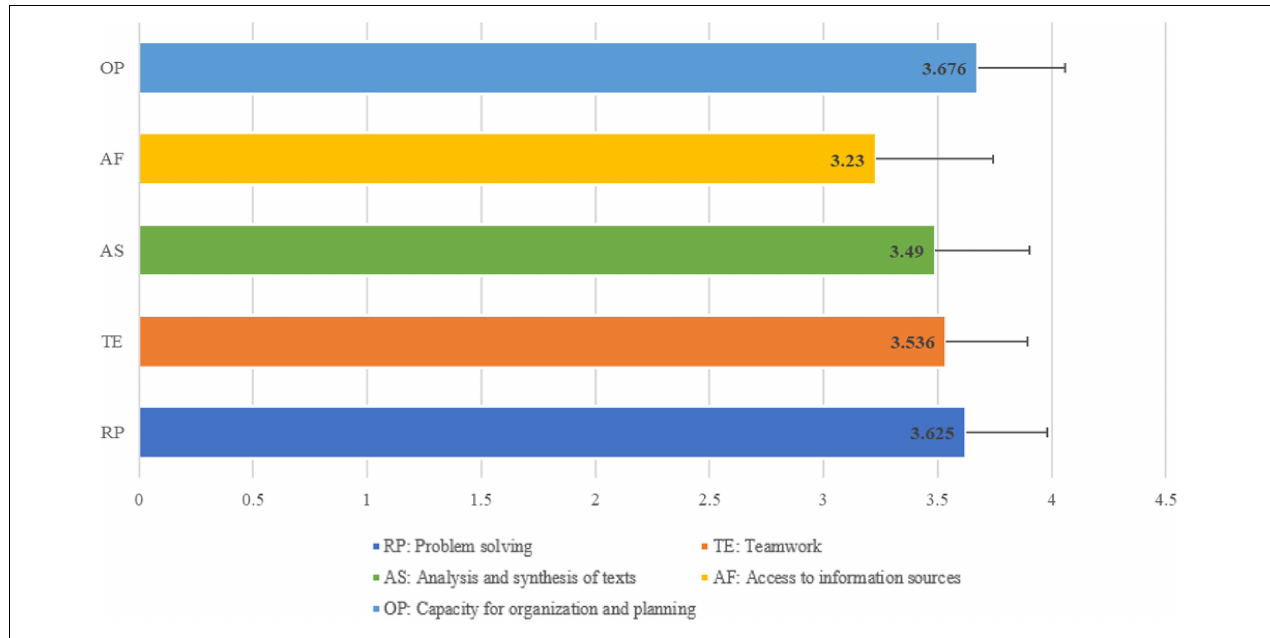
FIGURE 1 | Mean scores of basics